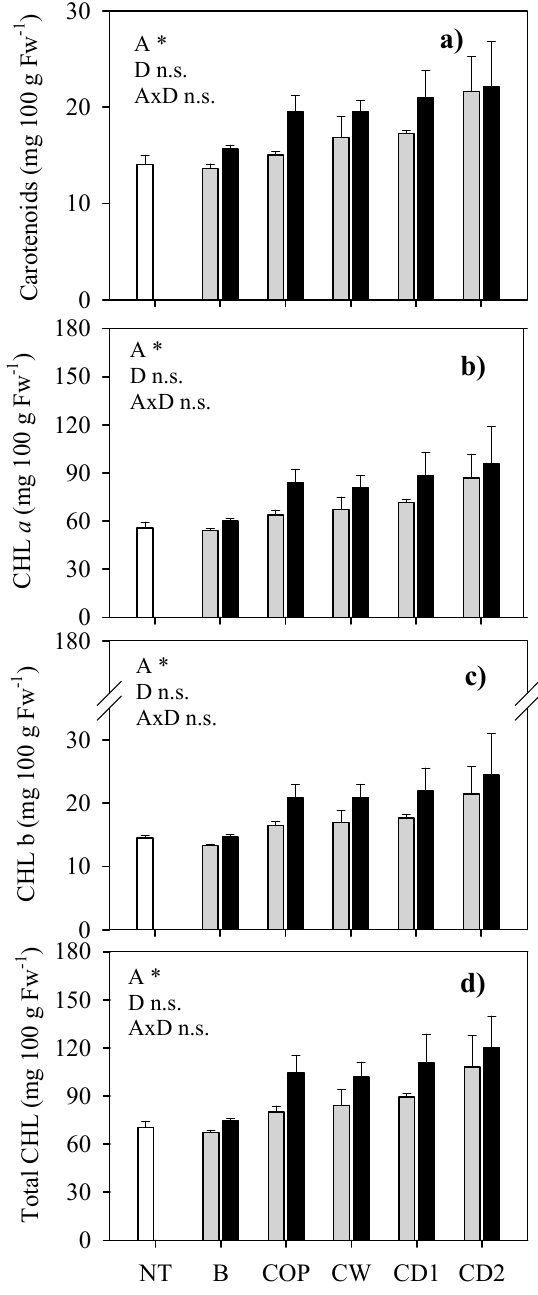
Figure 4. Carotenoids ( a ), chlorophyll a ( b ), chlorophyll b ( c ), and total chlorophyll ( d ) contents in Swiss chard treated with di ff erent organic amendments (B, biochar; COP, compost from olive pomace; CW, vermicompost from cattle manure; CD1, compost from 90% cattle anaerobic digestate with 10% wheat straw addition; CD2, compost from 79% cattle anaerobic digestate with 11% crop residues and 10% wheat straw addition), each added to provide 140 and 280 of kg N / ha, (grey and black bars, respectively), plus a non-treated soil or control (NT, white bar). Values are means (n = 4) ± standard errors. Data in each graph were analyzed by two-way ANOVA followed by a Duncan test at p ≤ 0.05. A, amendment; D, dose; *, p ≤ 0.05; n.s., not significant.